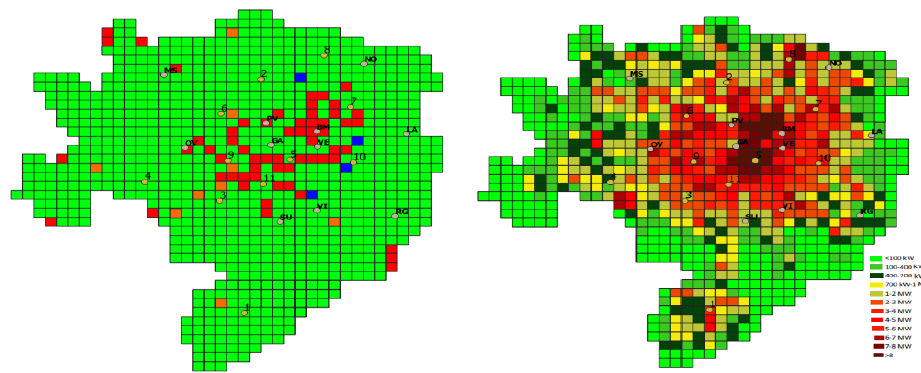
Figure 25. Output of the simulation results considering eleven new PSs. Yellow points are the new PSs, while gray is the existing ones.